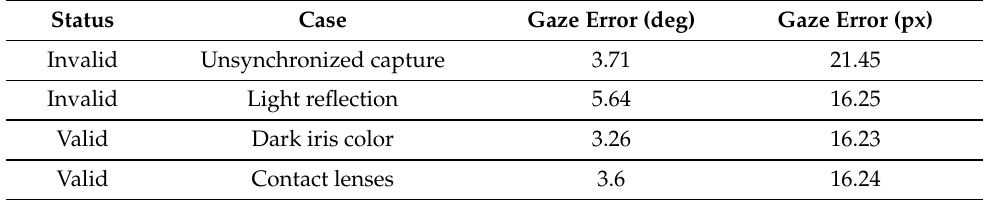
Table 3. Summary of special cases results (valid and